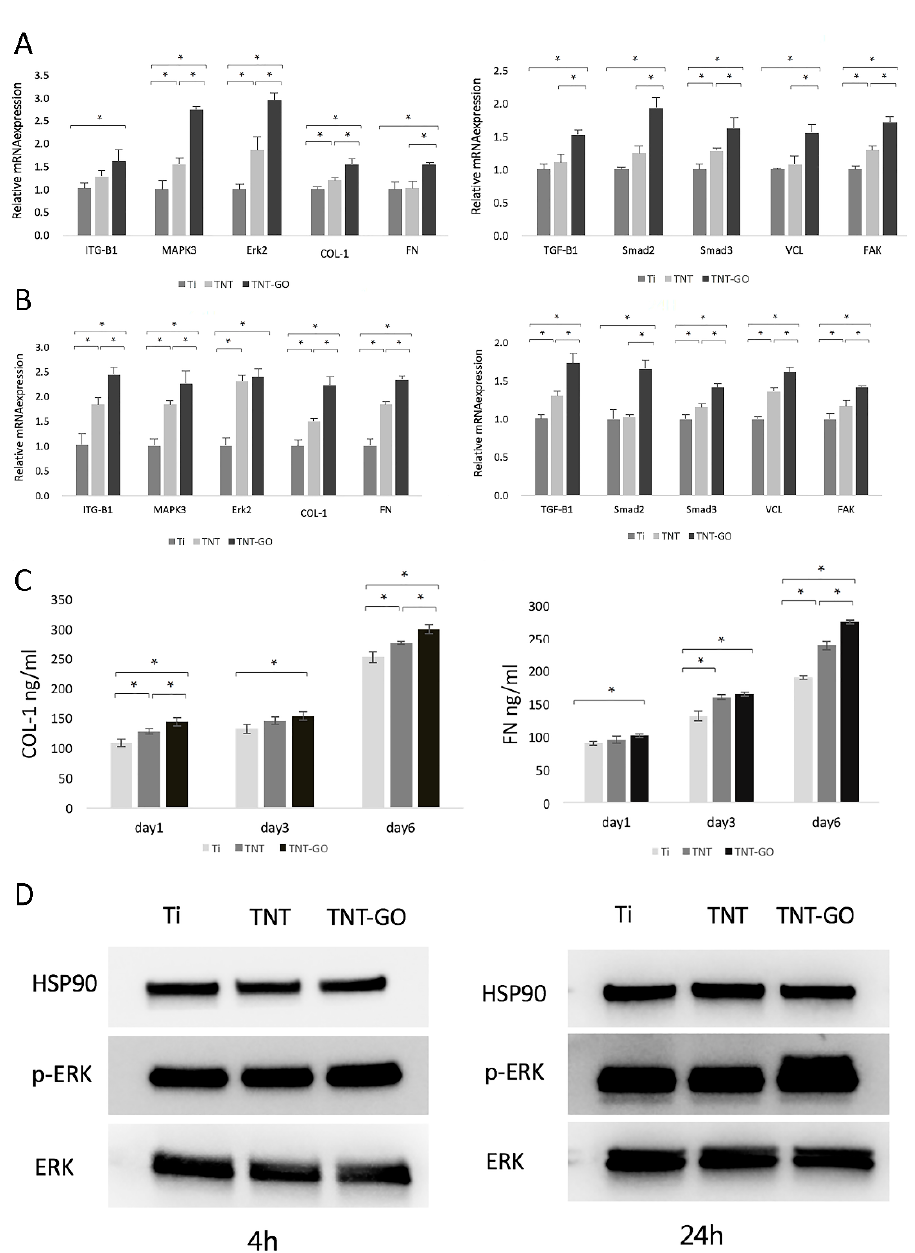
Figure 6. Gene expression of HGFs on the different surfaces after ( A ) 4 h and ( B ) 24 h; ( C ) ELISA results of COL-1 and FN in HGFs at 1, 3, and 6 d; ( D ) Western blot of ERK and p-ERK at 4 h and 24 h (* p <